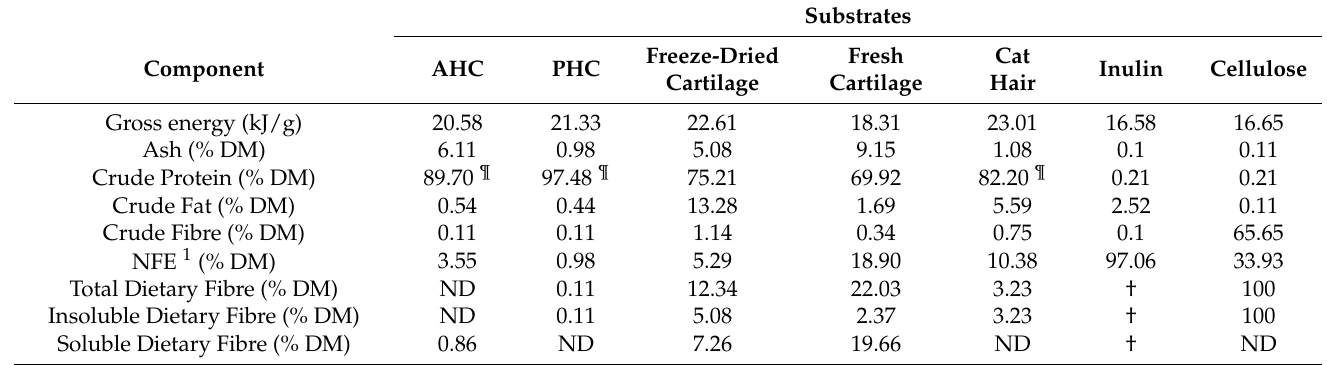
Table 1. Nutrient composition of substrates used for in vitro digestion and